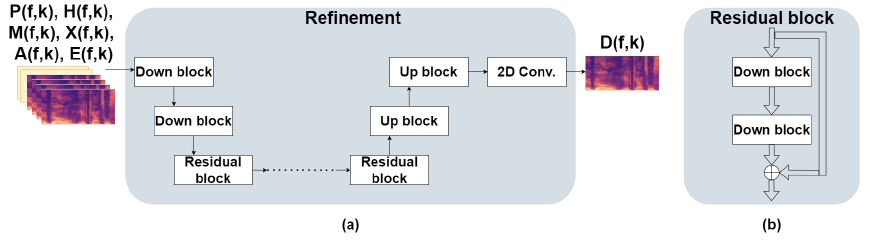
Figure 3. Structure of refinement model architecture and residual blocks. ( a ) Refinement model architecture. ( b ) Structure of the residual